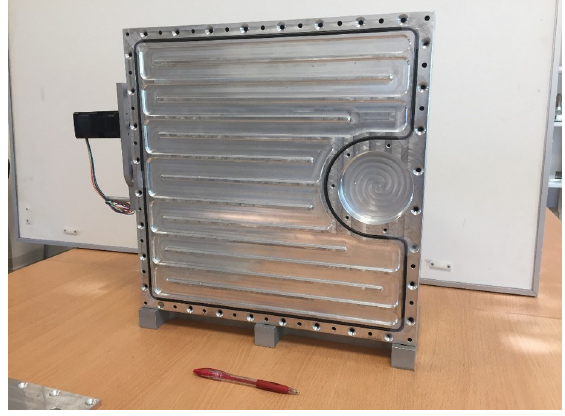
Fig. 4. Water cooling channels